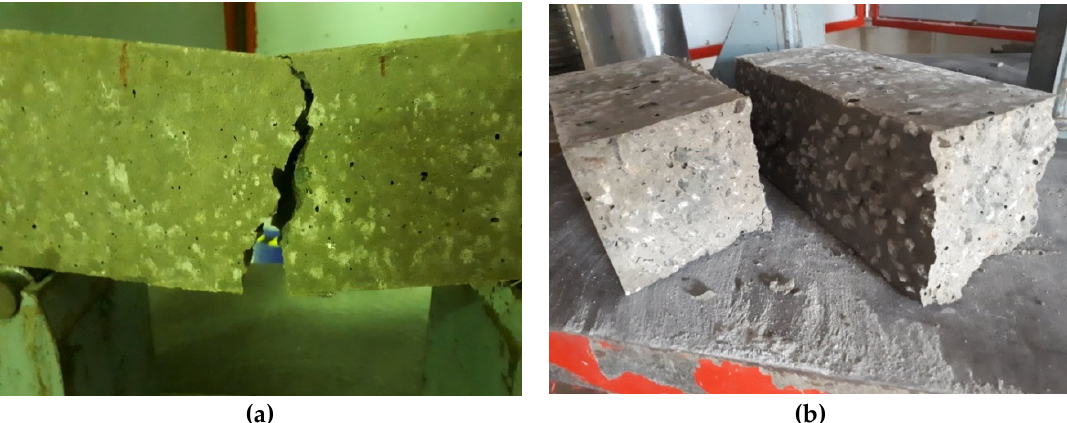
Figure 17. (a,b) Failure pattern for samples subjected to tension testing. Materials 2019 , 12 , x FOR PEER REVIEW